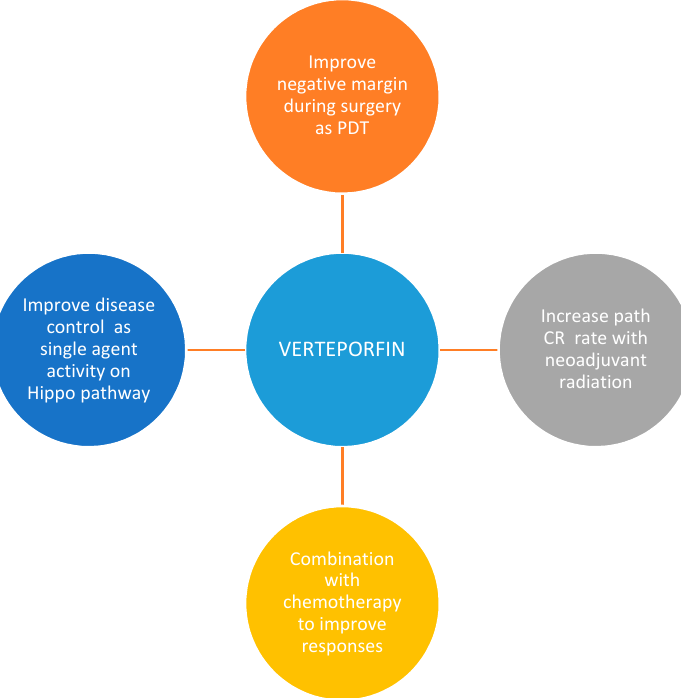
Figure 3. Verteporfin as PDT and as a Hippo pathway inhibitor can be used clinically in the management of localize and advanced STS. Path CR: Pathological complete response. PDT: Photodynamic therapy.